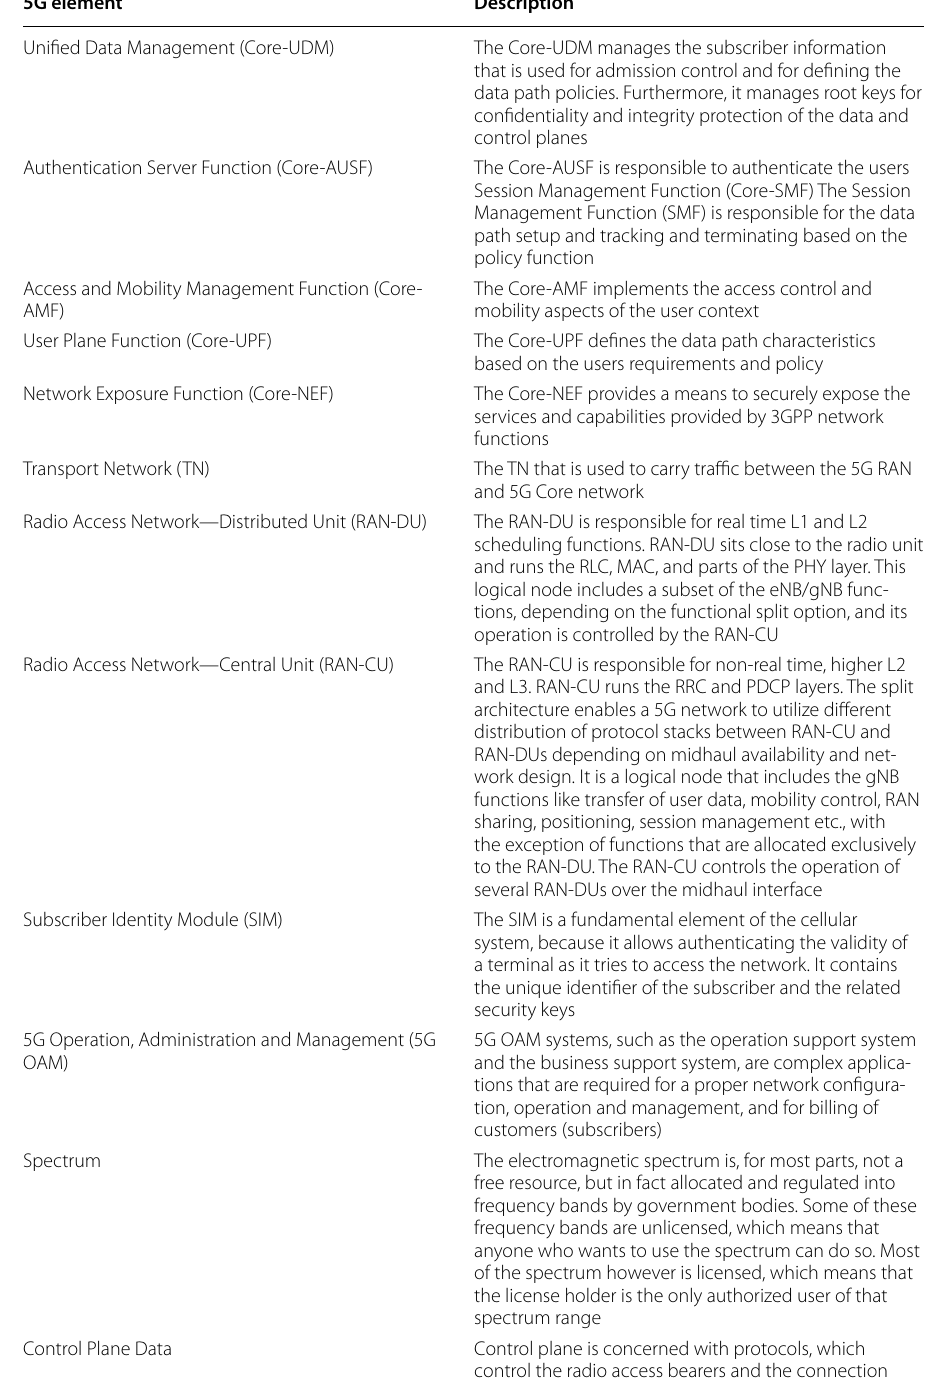
Table 4 Description of 5G